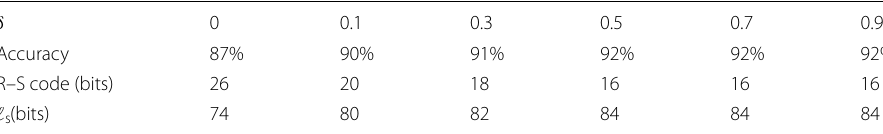
Table 2 Extraction accuracy under different δ